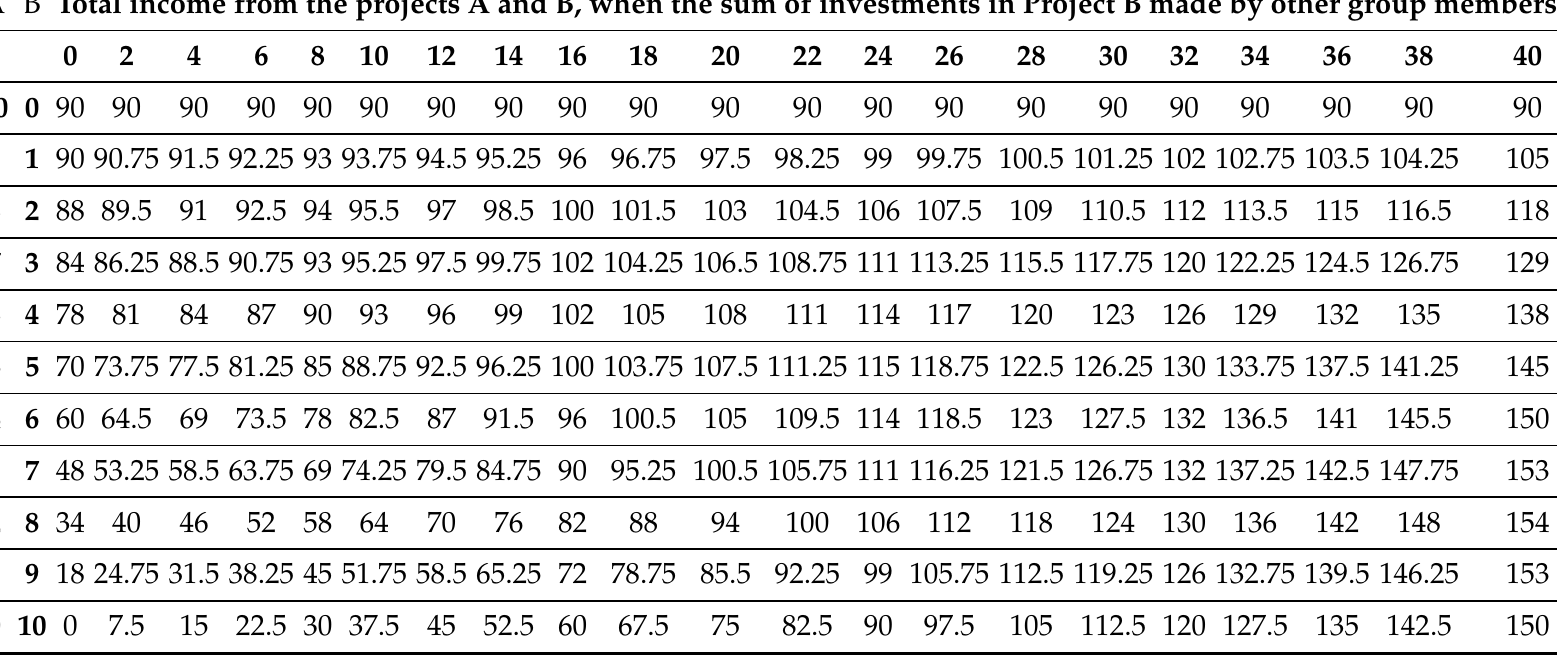
Table 3. Total income from the projects A and B per different total amounts of investments in the project B made by the other group members. The two leftmost columns list the investments in the projects A and B by the subject, respectively, and the uppermost row shows total amounts of investments made by the other group